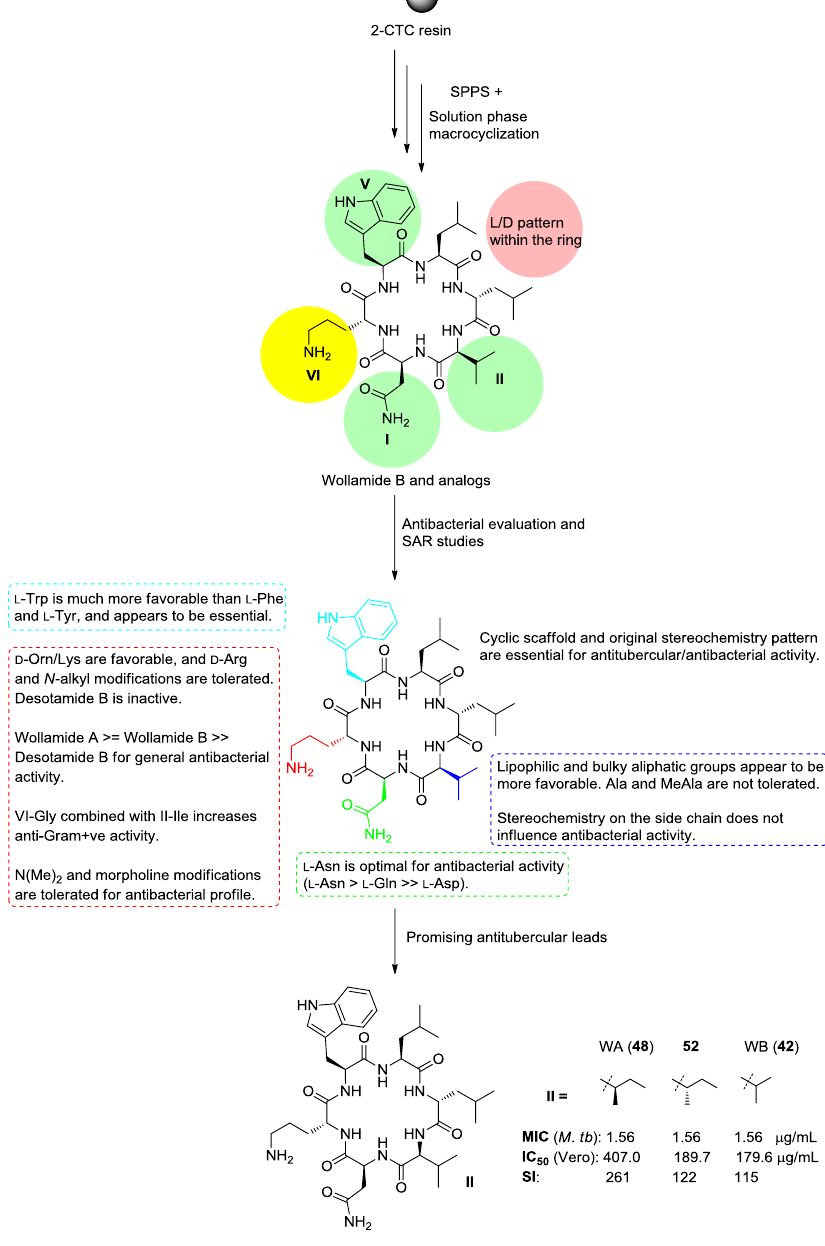
Figure 10. Synthesis and structure–activity relationship (SAR) studies of cyclohexapeptides 48 , 52 , and 42 .